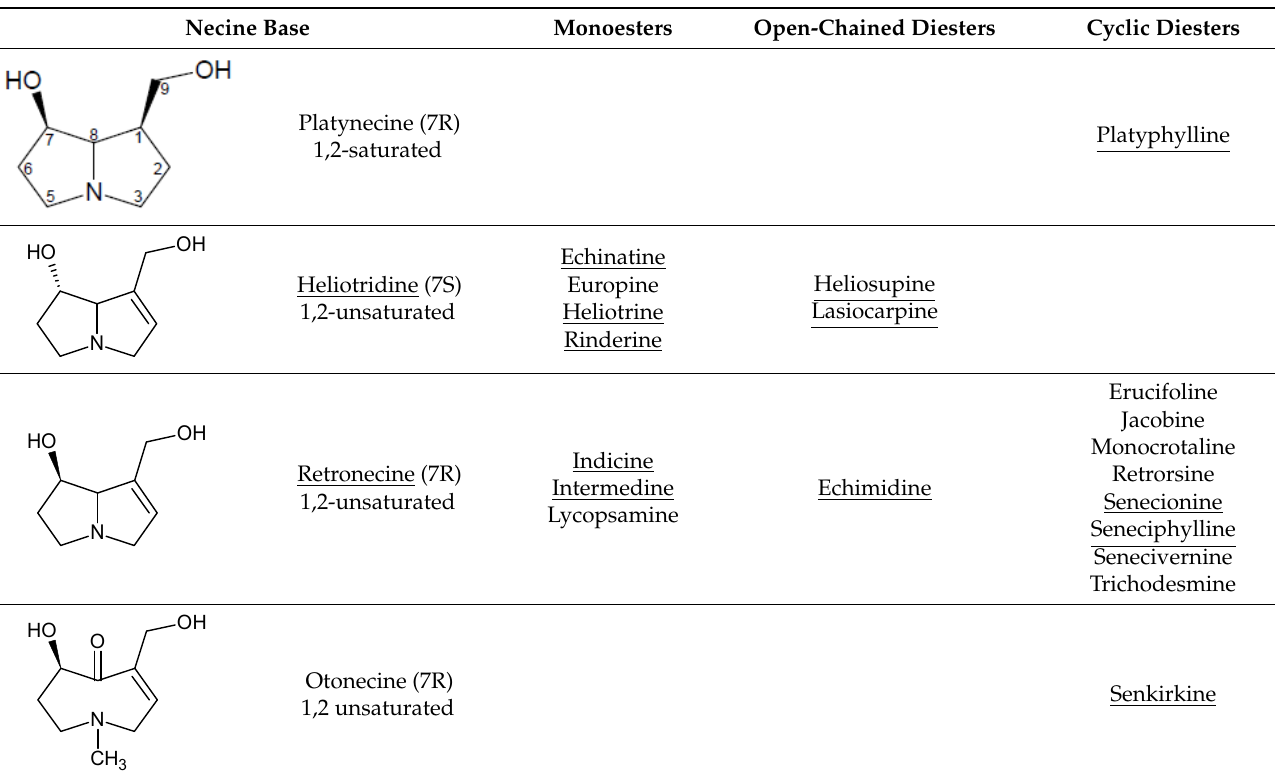
Table 1. Overview of different pyrrolizidine alkaloids (PAs) and their structural characteristics. For cytotoxicity studies, all listed esters and the free bases heliotridine and retronecine were used. The underlined PAs represent the reduced test set for all following experiments. Necine Base Monoesters Open-Chained Diesters Cyclic Diesters